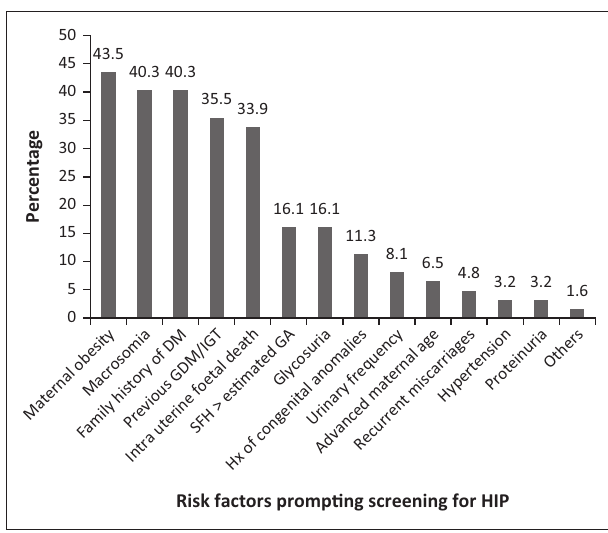
FIGURE 1: Risk factors prompting screening for hyperglycaemia in pregnancy among antenatal healthcare providers in healthcare facilities in Jos North, Plateau state, Nigeria, August to September 2019.